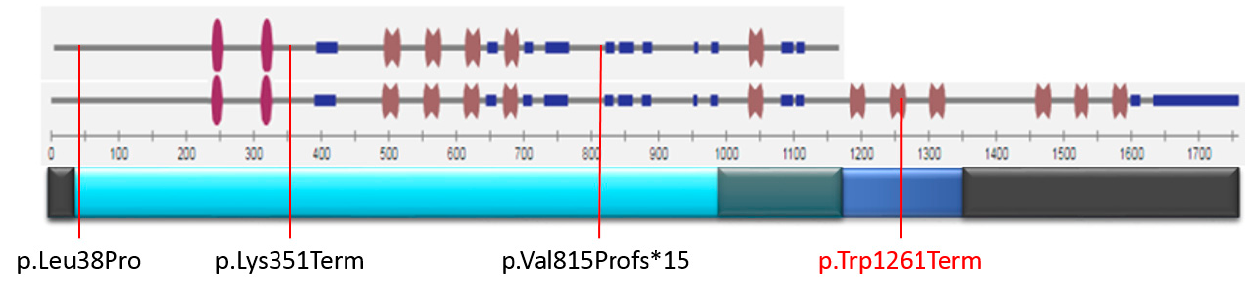
Figure 2. Domains of both CASZ1 isoforms and the NMD area with an indication of mutations on it. Numbers—base sequence;